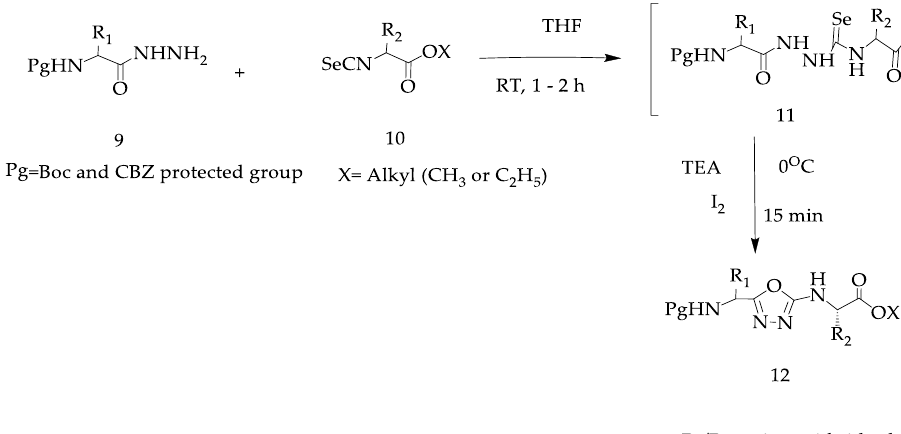
Scheme 1. Synthetic route of 2-amino-1,3,4-oxadiazole derivatives .